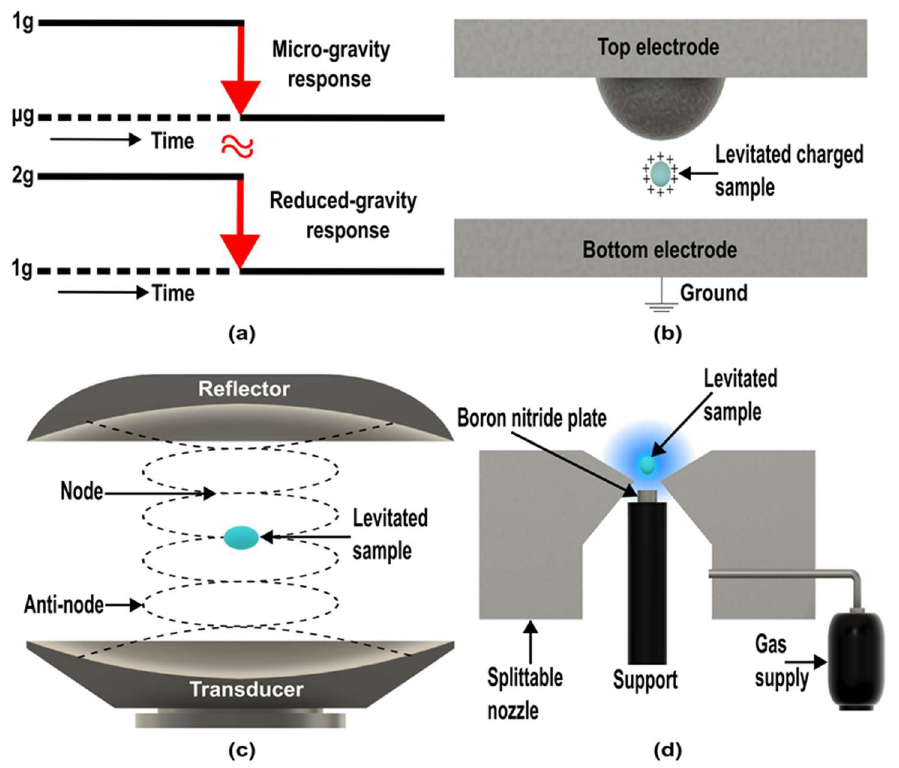
Figure 9. Principle of different possible microgravity simulators. ( a ) Reduce gravity paradigm. (Adapted with permission from [116]. Copyright 2016, Van Loon) ( b ) Electrostatic levitation. ( c ) Acoustic levitation. ( d ) Aerodynamic levitation. (Adapted with permission from [121]. Copyright 2021,